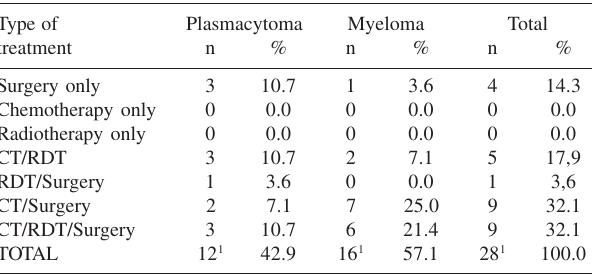
Table 9 - Type of treatment received by patients with plasmacytoma and by patients with plasmacytoma that progressed to myeloma (absolute and relative (%) frequency distribution)